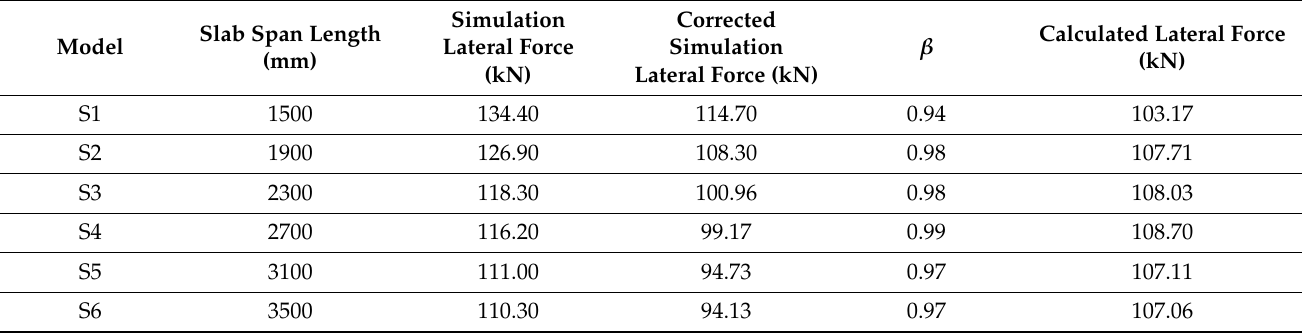
Table 1. FEM results for slab span length